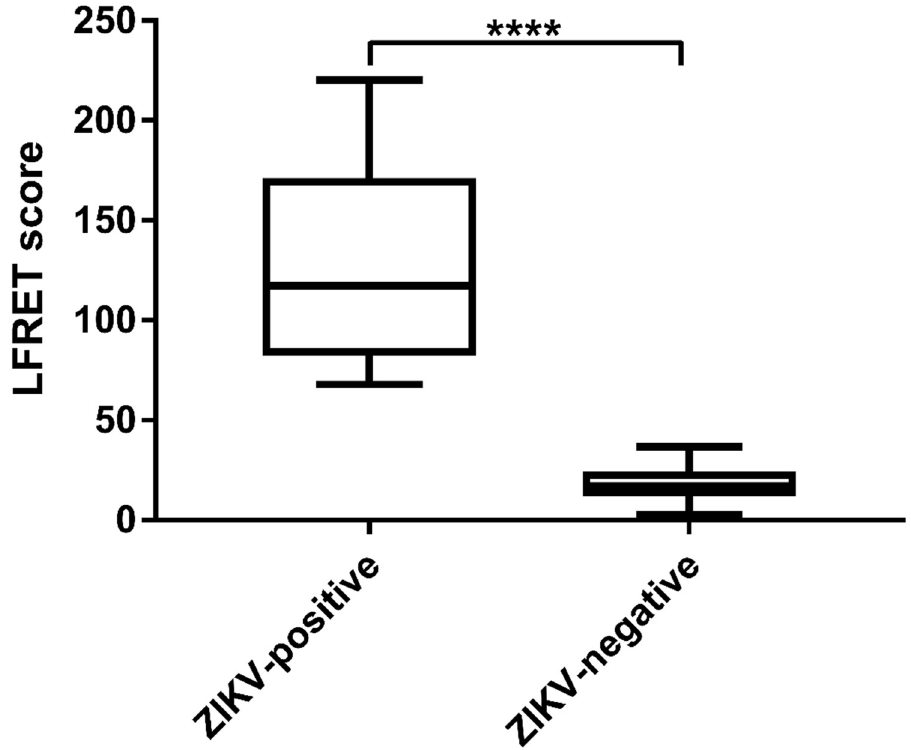
Fig 2. Class-independent LFRET scores for the first cohort of